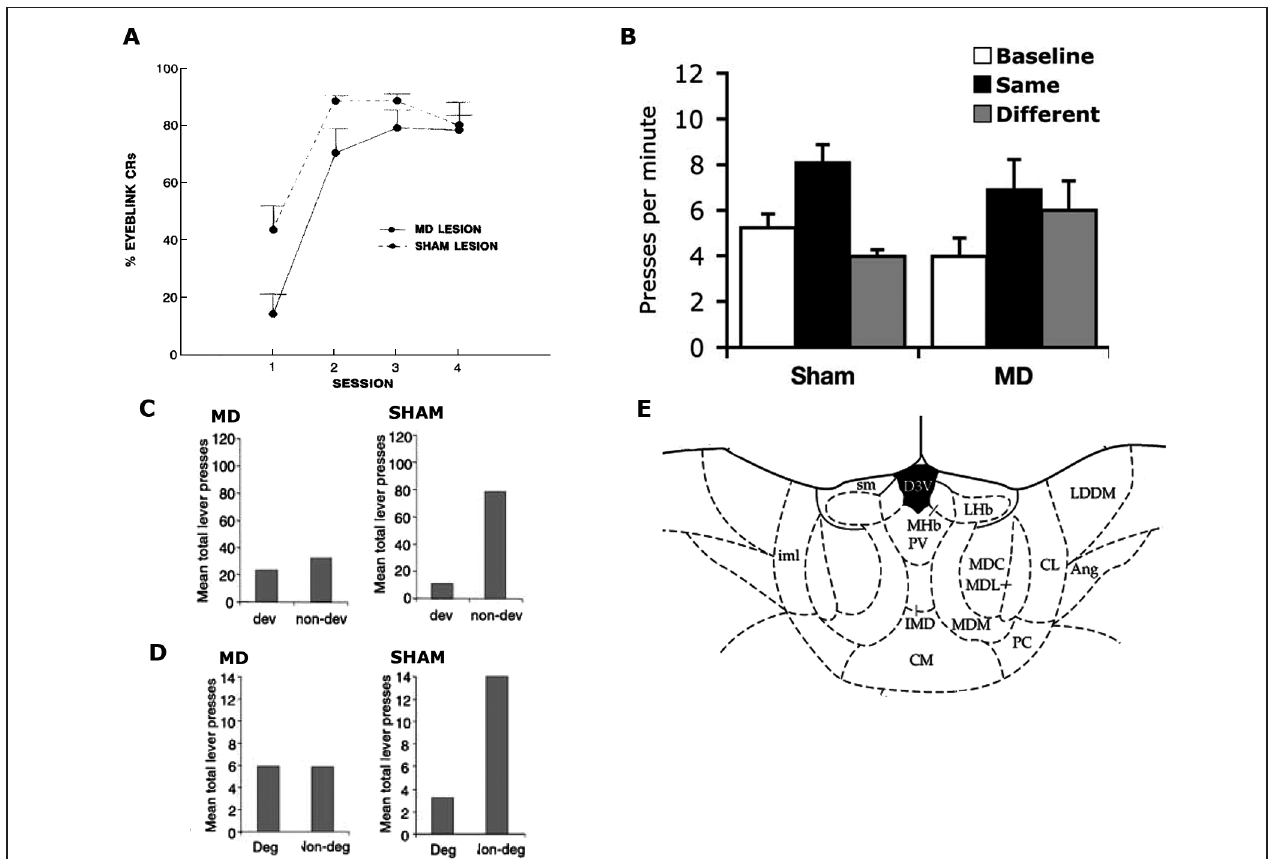
lesioned animals. (C,D) Reproduced from Corbit et al. (2003), examines sham and MD-lesioned animals. (C) Mean total